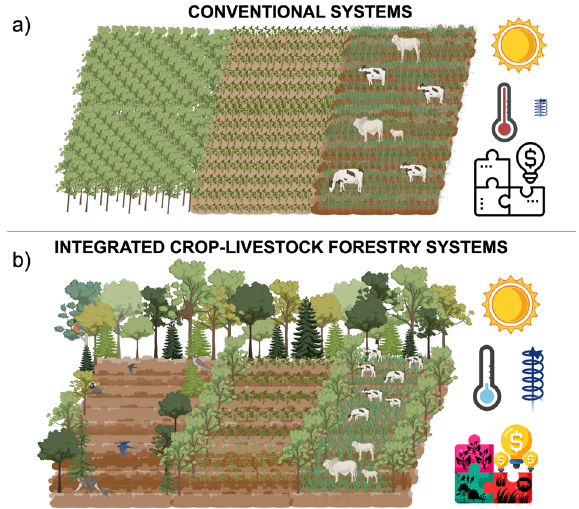
Fig. 3 Environment and economic aspects of conventional agricultural systems and Integrated Crop – Livestock – Forestry. The conventional system a is characterized by large areas of monoculture production with intensive management of the land, whereas the integrated system b offers more